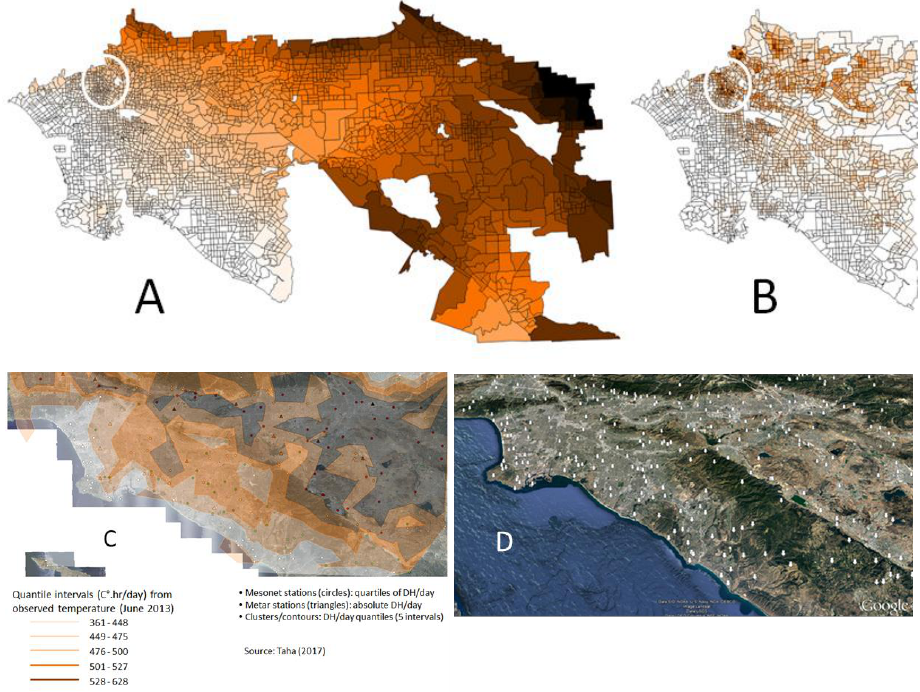
Figure 5. Los Angeles area UHII as the difference from reference points, showing the climate-archipelago effect. Lightest color is 6 DH/day; darkest color is 190 DH/day (°C.hr/day). ( A ) UHII; ( B ) UHII weighted by population density; ( C ) clustering of observations-based DH/day (absolute) at each monitor for June 2013; ( D ) locations of 329 monitors in the region (basis for 4C). The Los